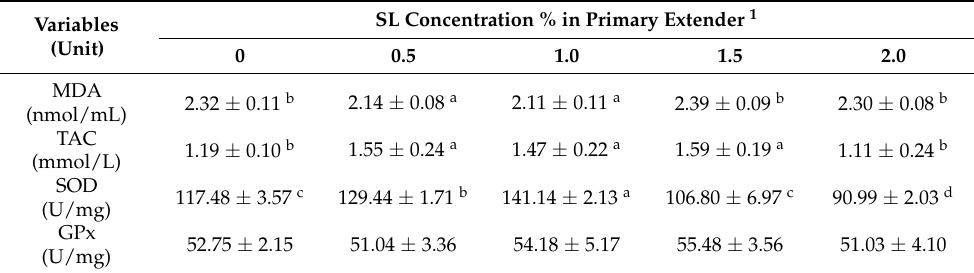
Table 3. Malondialdehyde (MDA), total antioxidant capacity (TAC), and superoxide dismutase (SOD) and glutathione peroxidase (GPx) activities of post-thawed rooster sperm treated with different concentrations of soybean lecithin (SL) (n = 20 roosters and n = 95 ejaculate). Variables (Unit)